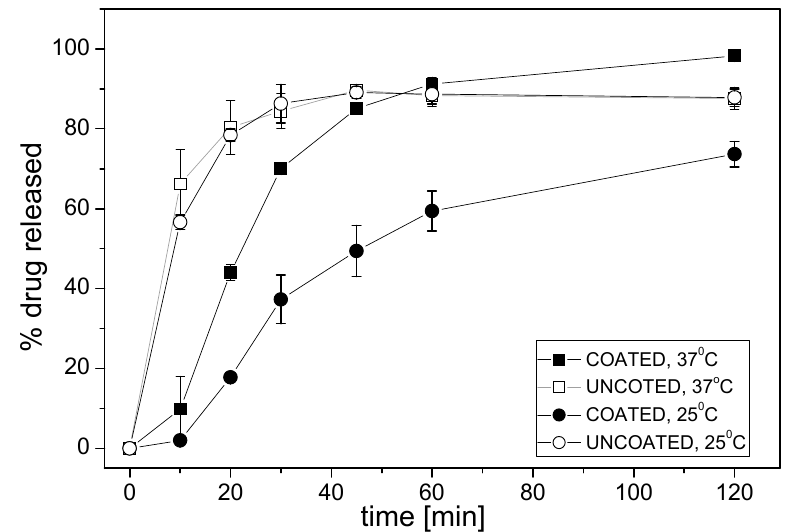
Figure 2. Dissolution profiles of valsartan from minitablets coated with Eudragit E or without coating (phosphate buffer pH 6.5; mean ± SD; n = 3).